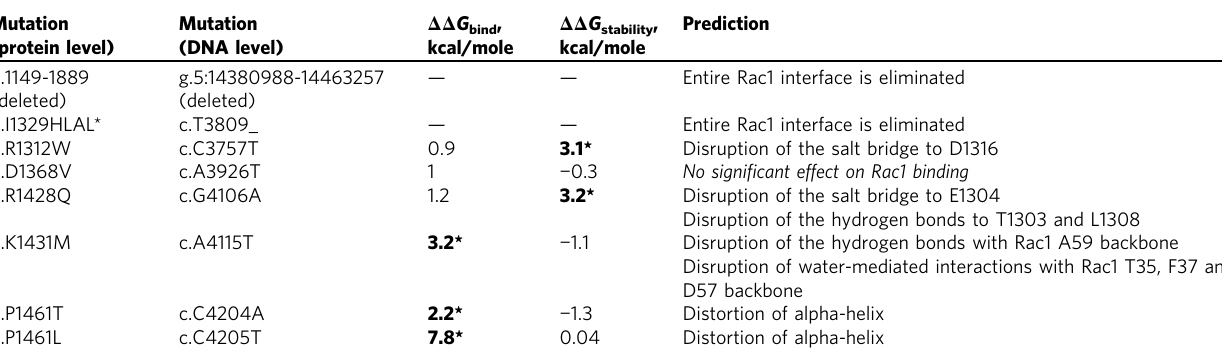
Predictions of free energy change in protein domain stability ( ΔΔ G stability ) and binding of Trio-GEF1 and Rac1 ( ΔΔ G bind ) for mutant proteins and expected effects of mutations on the ability of Trio to activate Rac1. Starred ΔΔ values indicate predicted inhibition of Rac1 activation. Position of amino-acid mutations from NP_009049.2 and position of corresponding nucleotide mutations from Human (GRCh37) or